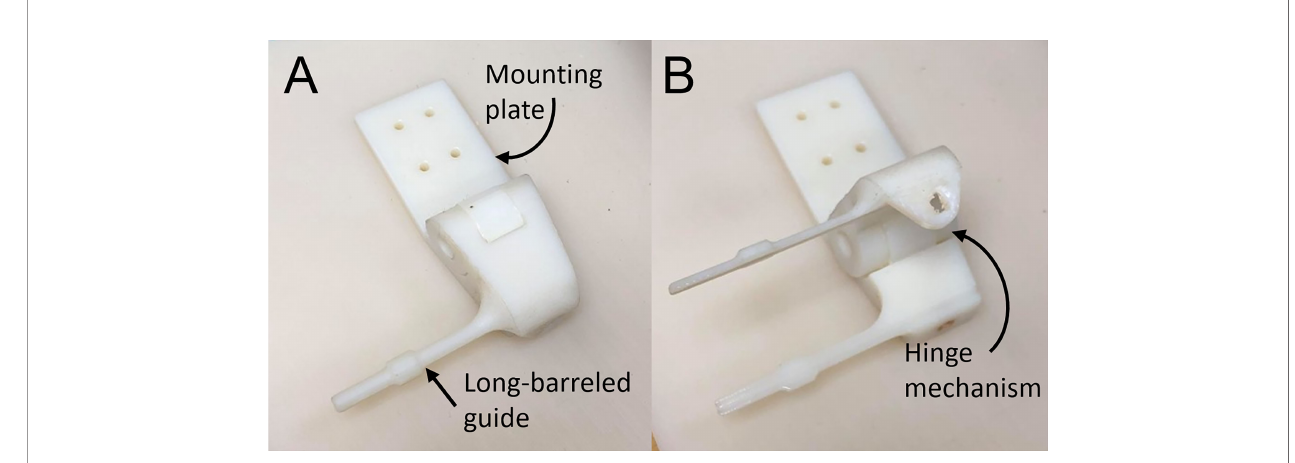
FIGURE 2 | End effector needle guide in (A) closed and (B) open con